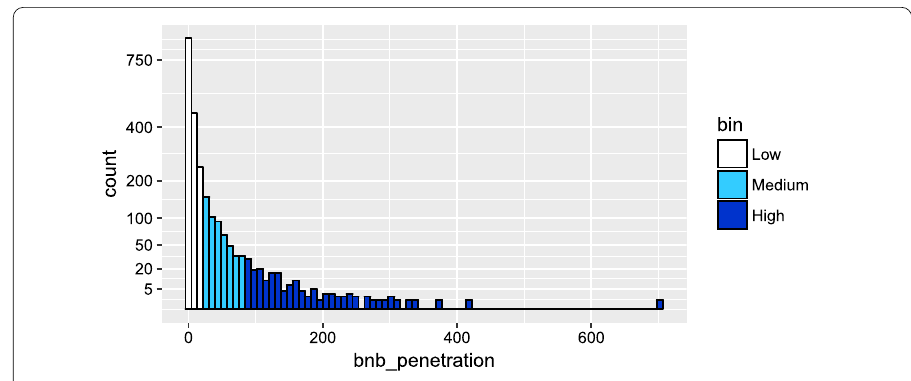
Figure 1 Frequency distribution of Airbnb penetration against the three produced bins: ‘low’, ‘medium’ and ‘high’ Airbnb